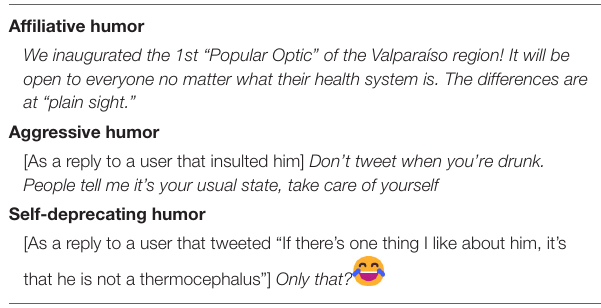
TABLE 1 | Examples of humorous